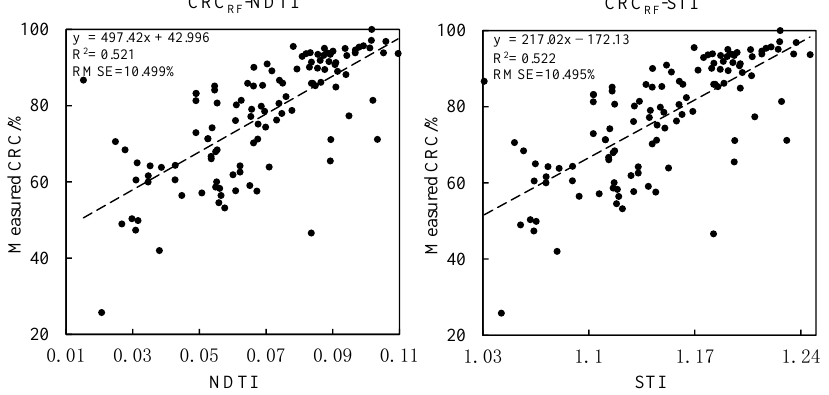
Figure 8. Estimation of wheat coverage R2 based on Sentinel-2 image data index.